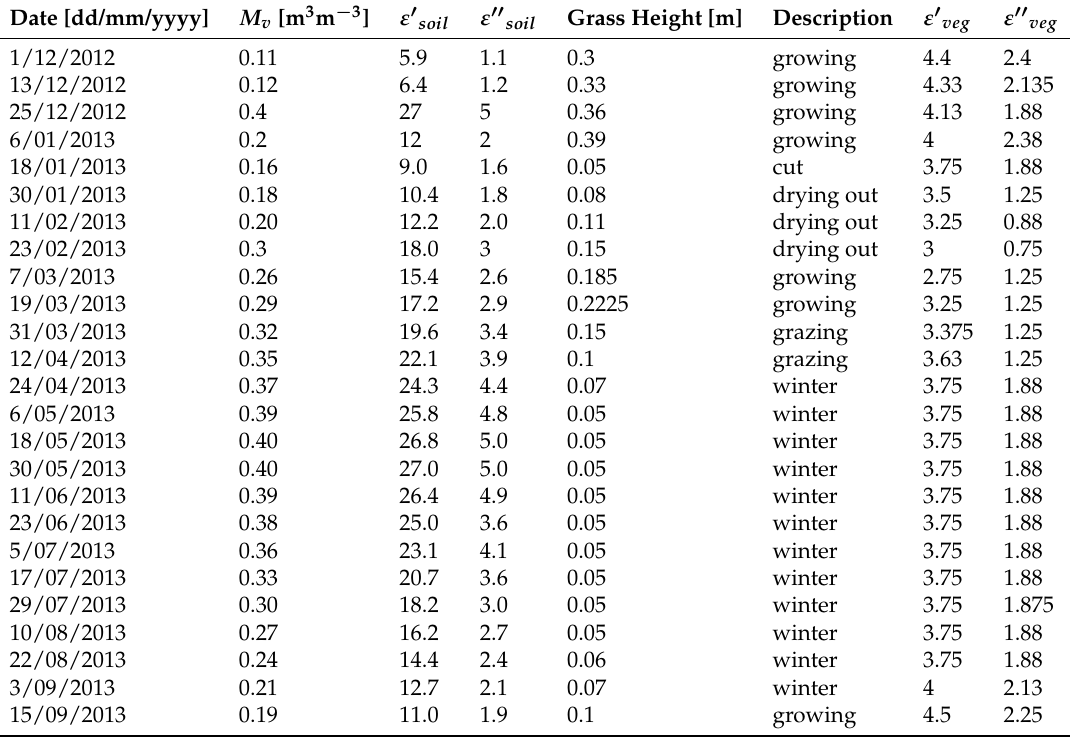
Table 2. Material properties at C-band microwave frequencies of the “pasture over a year” experiment. M v = soil moisture; veg = vegetation. Conversion to X-band dielectric properties was performed using Equation